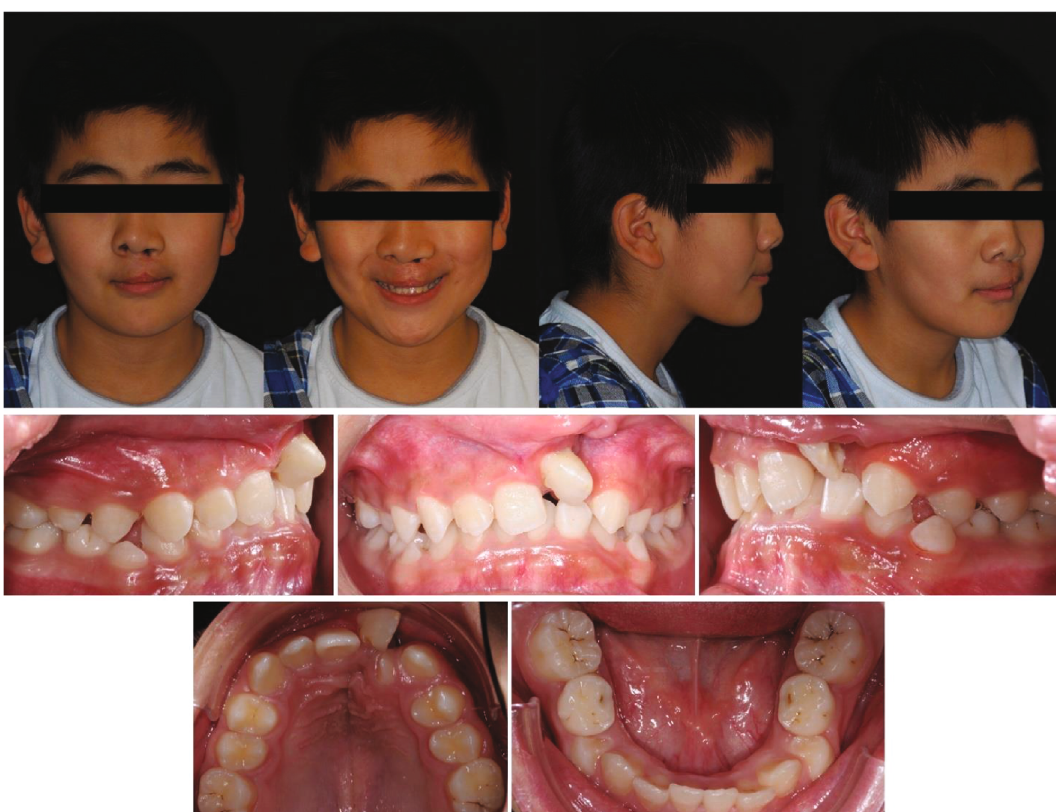
Figure 2: Initial photographic